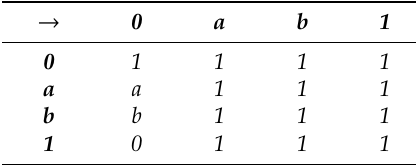
Table 4. The operation → on X .